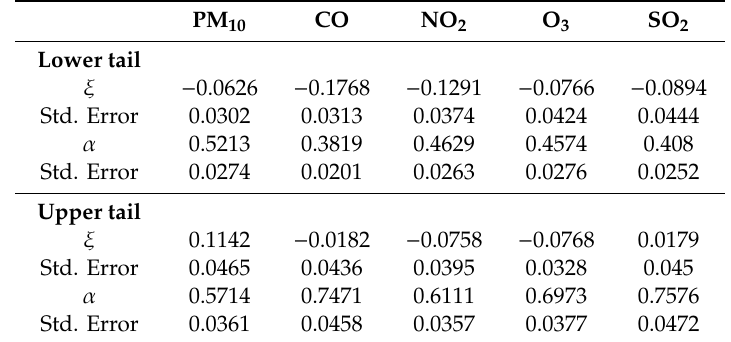
Table 3. Correlation among pollutant